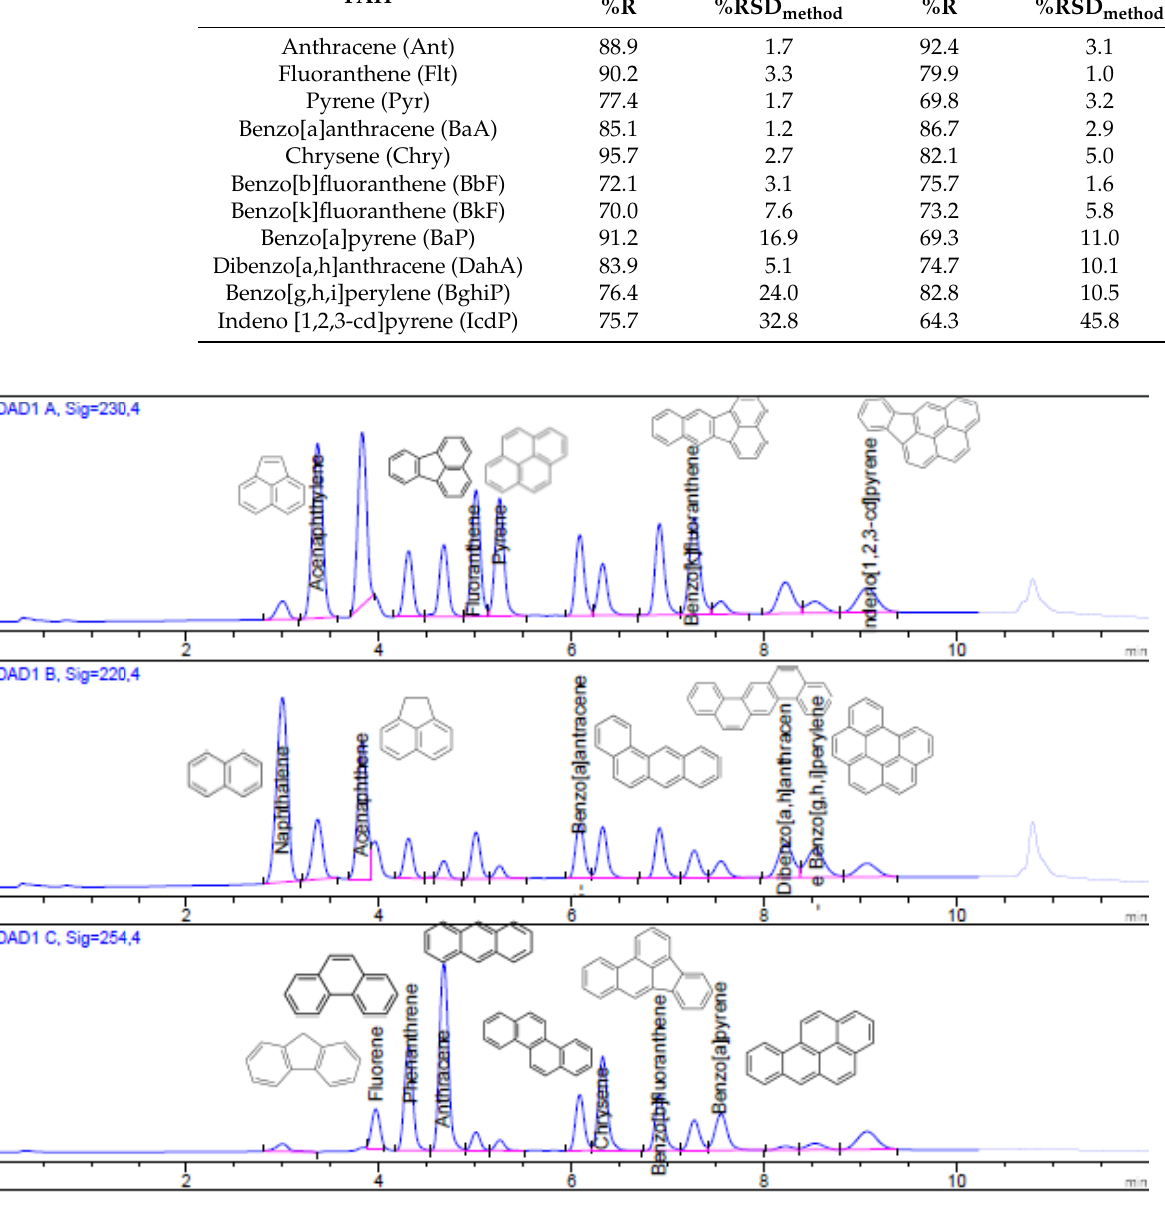
Figure 1. HPLC chromatogram of the certified standard at a concentration of 1000 μg L −1 of 16 PAHs at λ = 230 nm, 220 nm , and 254 nm. Each PAH was calibrated in the UV wavelength (λ) where their signal was greatest.